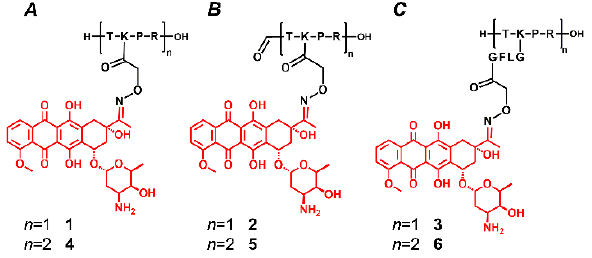
Figure 2. Schematic structure of the novel daunomycin-tuftsin bioconjugates.